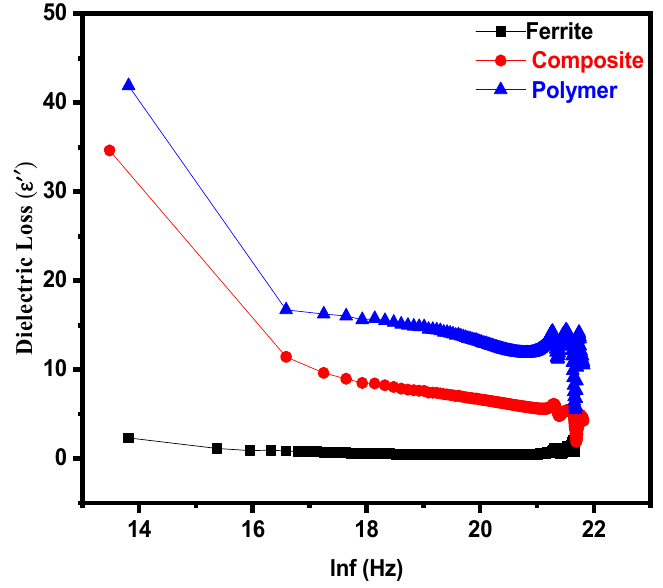
Figure 3. The dielectric loss of Y-type hexaferrite Sr 2 Co 2 Fe 12 O 22 , composite (Sr 2 Co 2 Fe 12 O 22 + PPy-DBSA) and polymer PPy-DBSA.